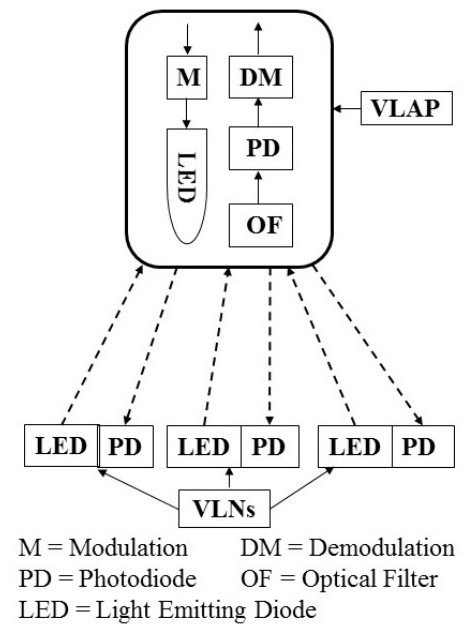
Figure 1. The common indoor optical wireless network (OWN)